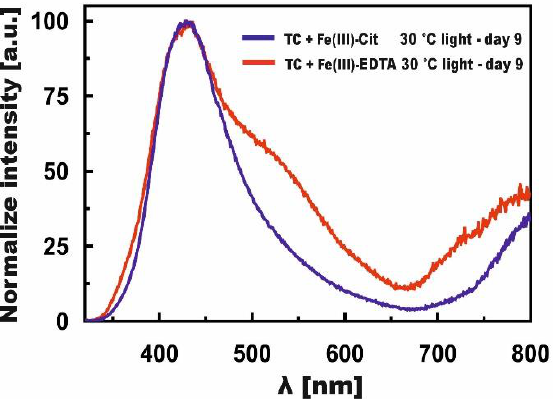
Figure 7. Normalized, final fluorescence spectra of TC in the presence of Fe(III)-Cit — blue line, and Fe(III)-EDTA — red line.